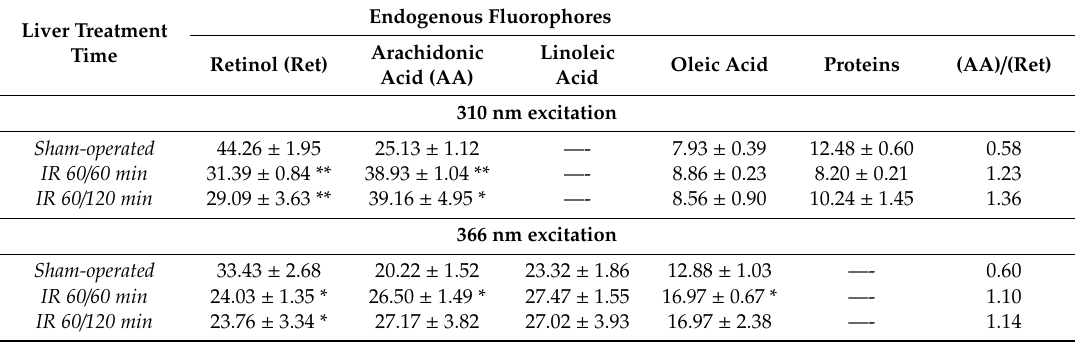
Figure 5. Examples of curve fitting analysis of spectra recorded under ( A – C ) 310 nm and ( D – F ) 366 nm excitation from serum of sham operated ( A , D ), I/R 60/60 min ( B , E ) and I/R 60/120 min ( C , F ). Spectra are normalized to the maximum peak value. AF spectral components are defined by colors. Dashed lines represent extrapolated part of curves from Peak fit program (310 nm excitation, left side of spectra recorded in the 390–630 nm interval) or undefined components. Goodness of fitting was verified by analysis of residuals (inset graphs) and by coefficient of correlation (r 2 ≥ 0.95). Table 2. Relative contribution (%) of the different endogenous fluorophores to serum AF spectral area, estimated by curve fitting analysis (Means ± S.E.).